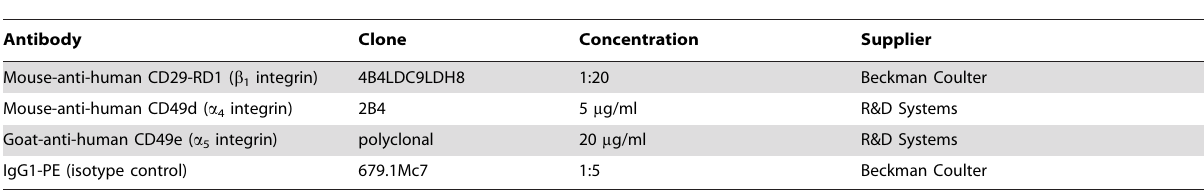
Table 3. Antibodies for integrin inhibition